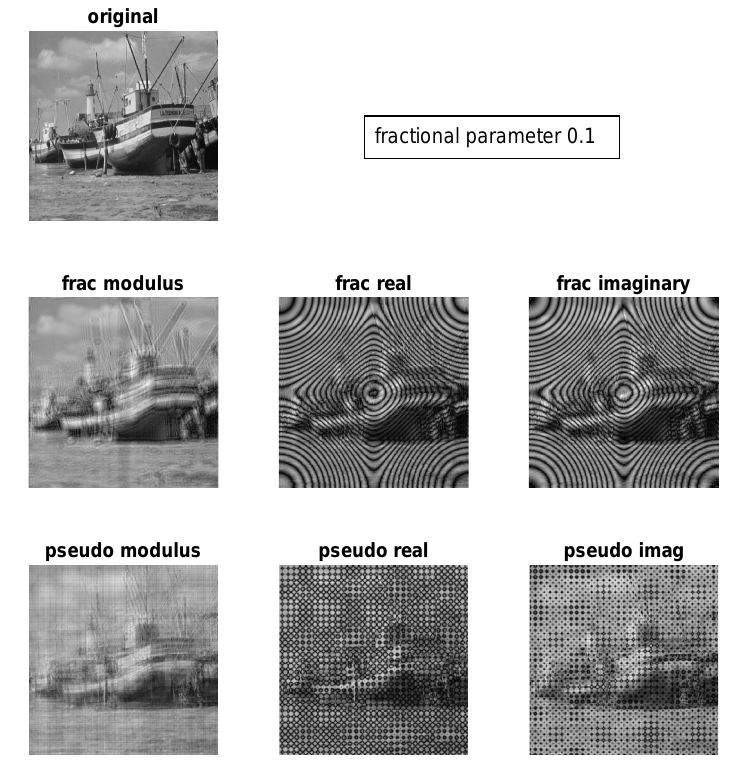
Figure 2. Comparison of DFrFT and DPFrFT of the grayscale image “Boat” for fractional parameter a =